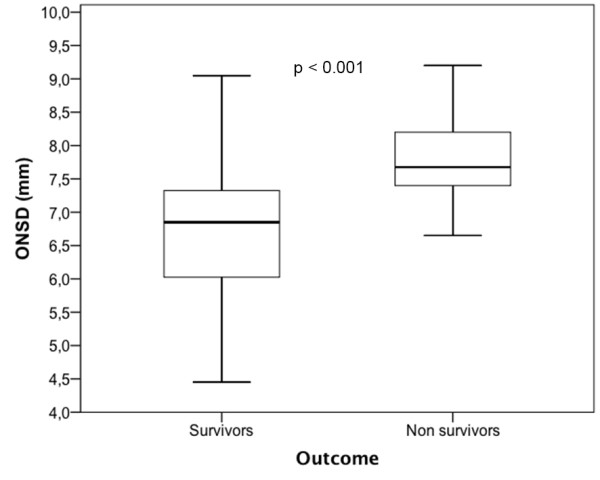
Box plot of optic nerve sheath diameter (mm) comparing survivors and non-survivors among severe traumatic brain injury patients.